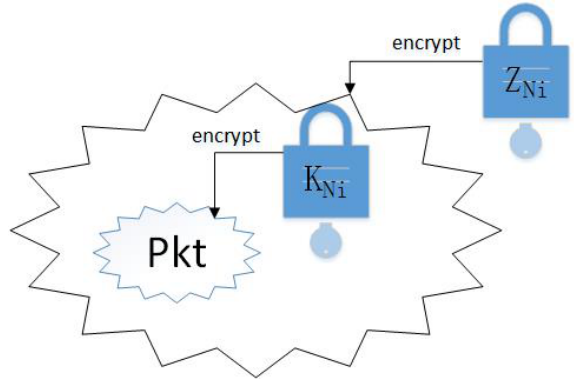
Figure 3. Packet Structure of Encryption Route